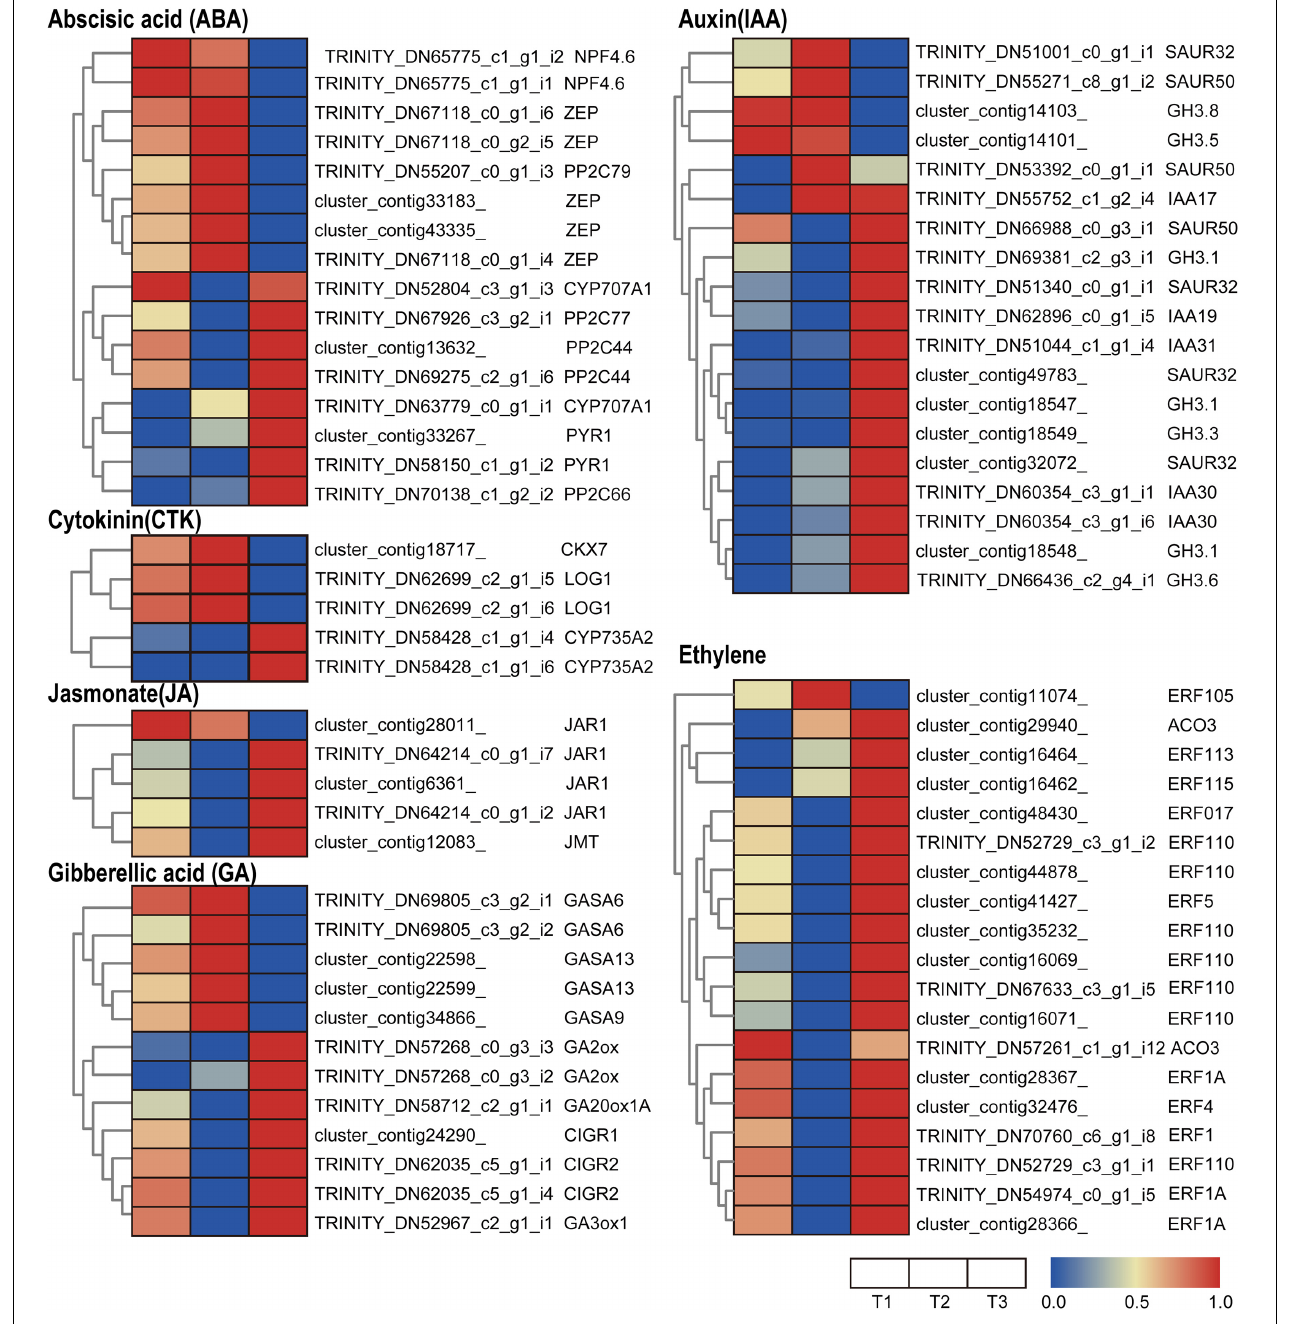
FIGURE 4 | Heatmap of the expressed genes assigned to hormone signal transduction pathways in the three petal transcriptomes, T1, T2, and T3. Red and blue colors indicate upregulated and downregulated transcripts, respectively.